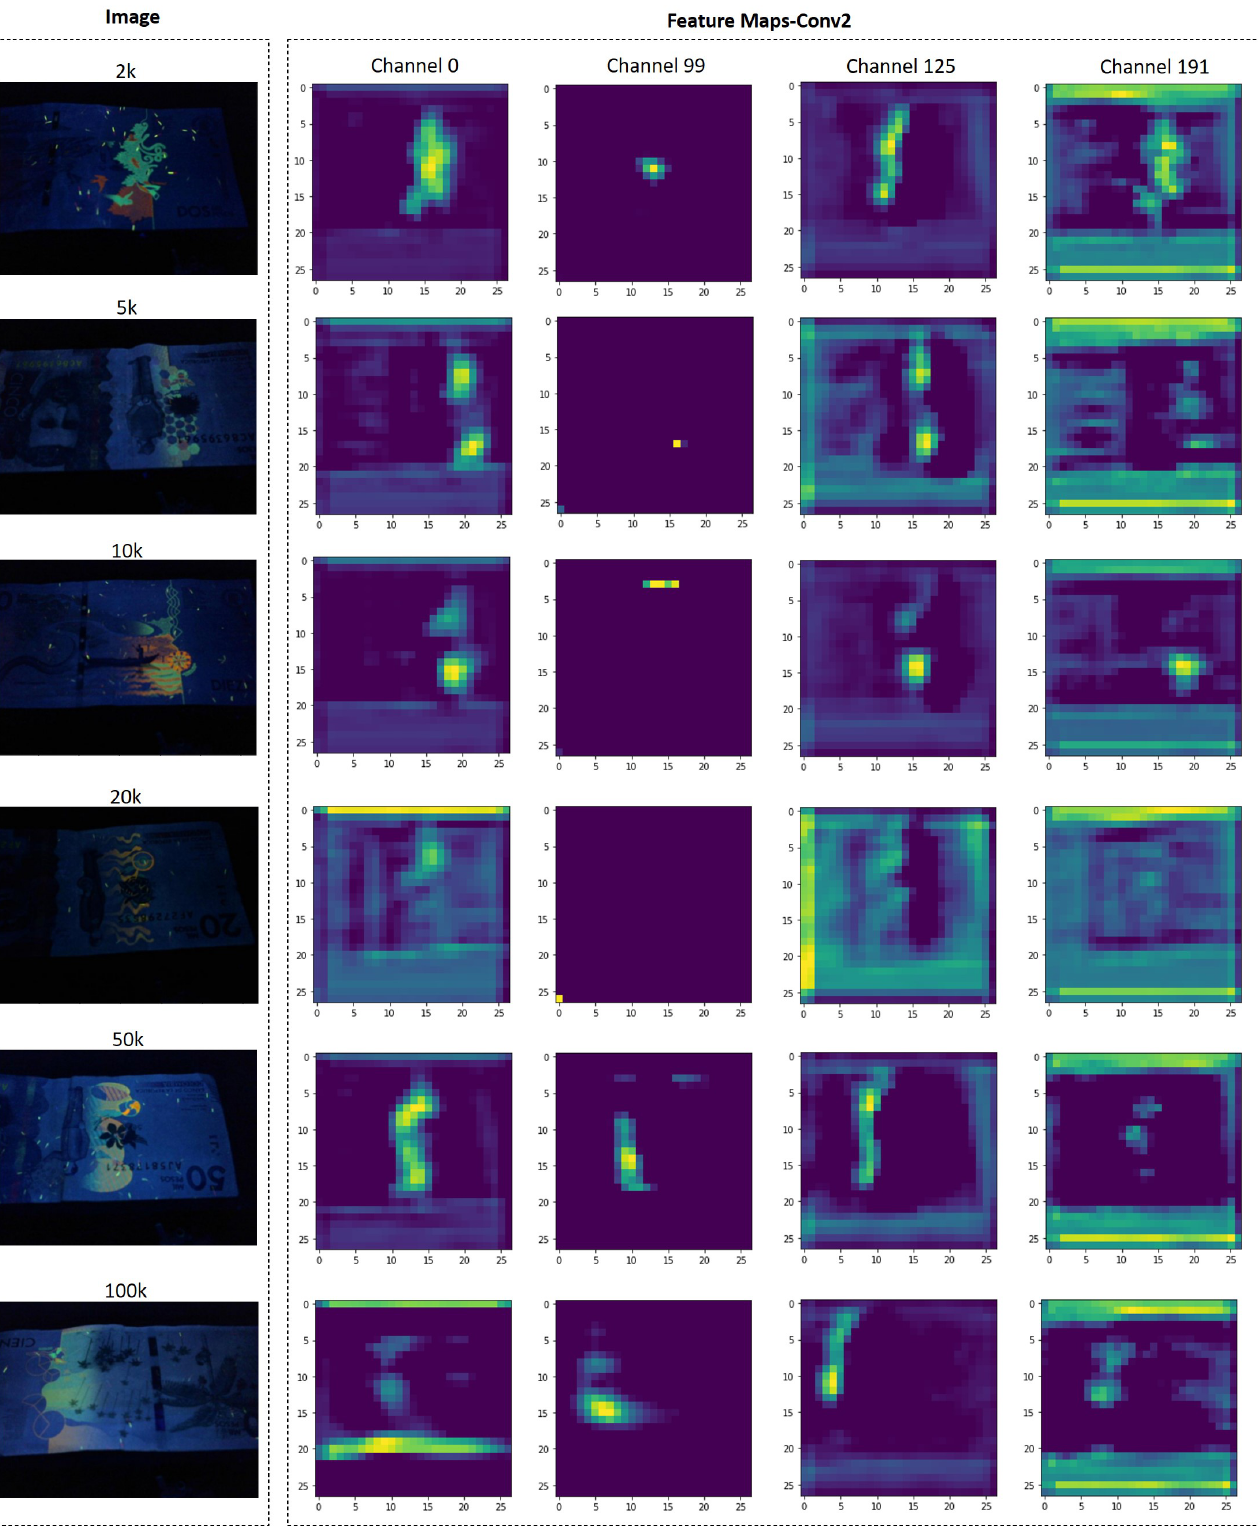
Figure 13. Examples of feature maps for original